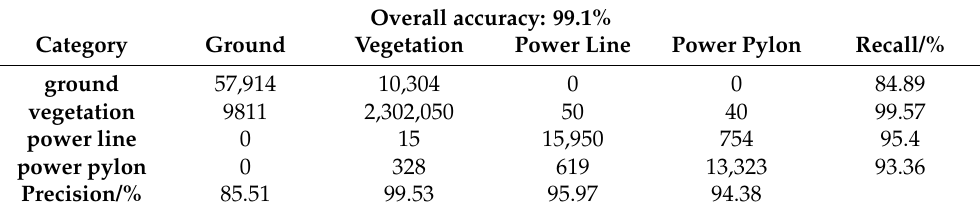
Table 4. Confusion matrix for classification of region